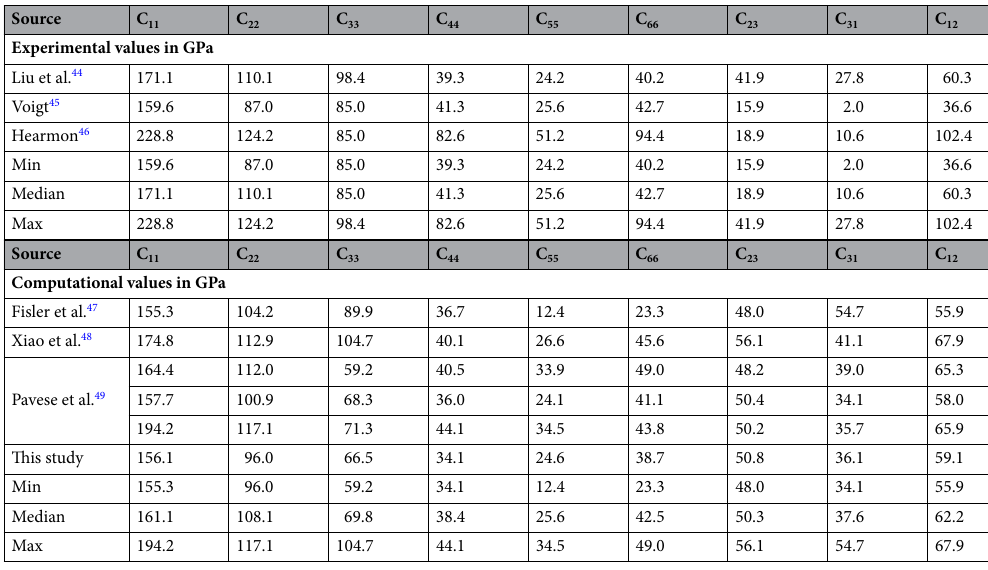
Table 1. Stiffness values for aragonite: Experimental and computational stiffnesses (C ij ) for aragonite crystals from the literature as well as stiffnesses computed in this